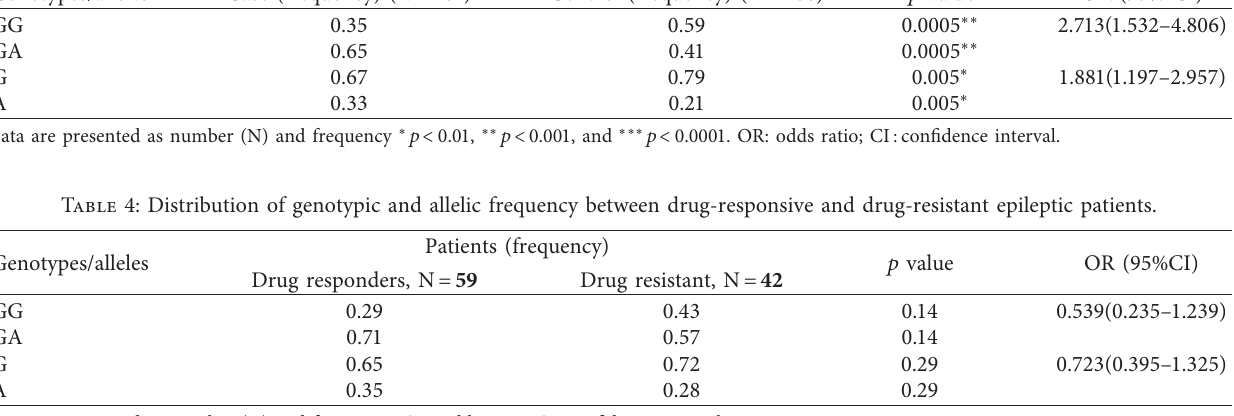
showing predicted functional association. Different line colors show the evidence types for the association. Red lines show the fusion evidence, yellow lines show miming evi- dence, blue line show database evidence, and black lines show coexpression evidence.